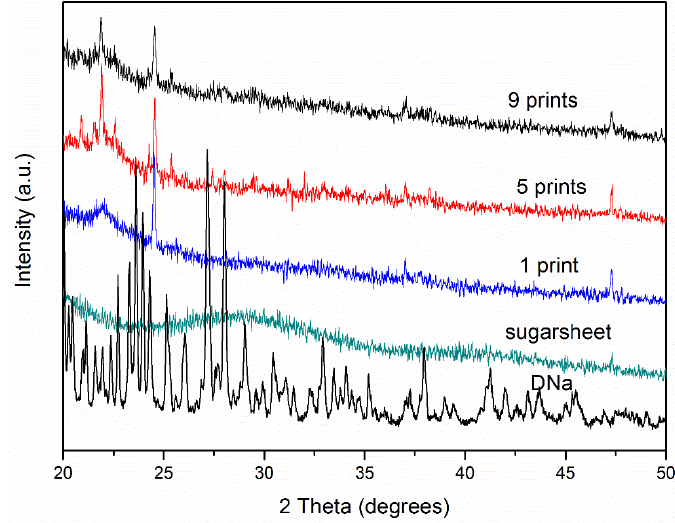
Figure 4. X ‐ ray diffractograms of pure components and formulations.